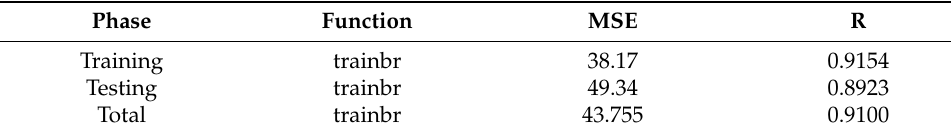
Table 5. Summary of BR algorithm model assessment parameters.